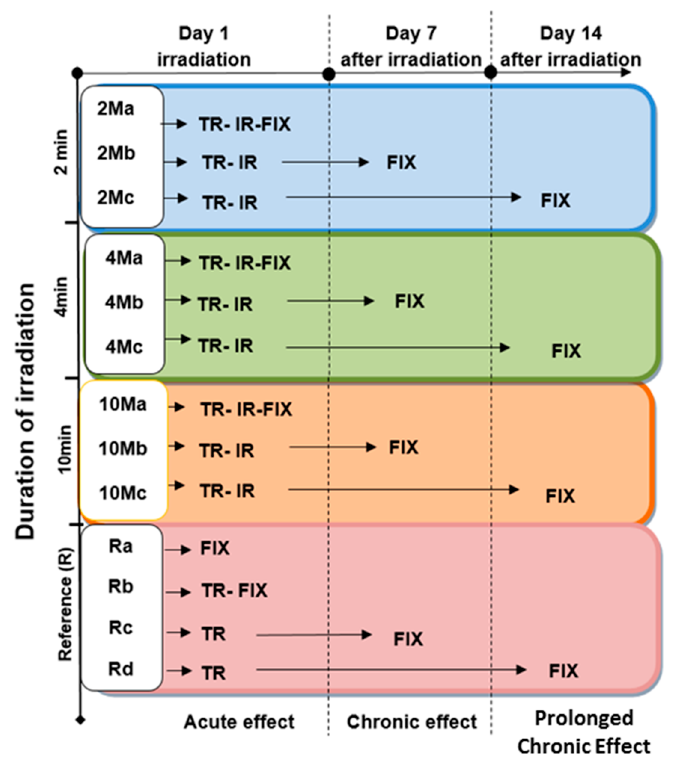
Figure 1. Experimental Schematic of H1299 human lung cancer cells monolayer irradiated by millimeter wave (MMW) for 2, 4, and 10 min in 35 mm dishes. The e ff ects observed in the irradiated cells were compared to two types of control cells (see methods)—(i) the cells that remained in the incubator during the entire experiment, and (ii) the cells that were transferred to the irradiation setup and brought back together with the experimental groups but were not irradiated.